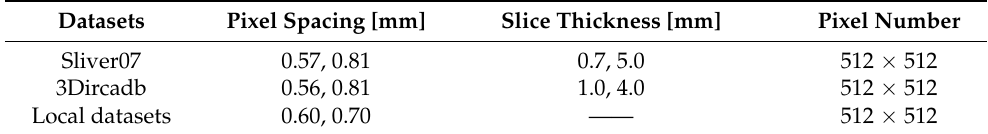
Table 1. Datasets information.